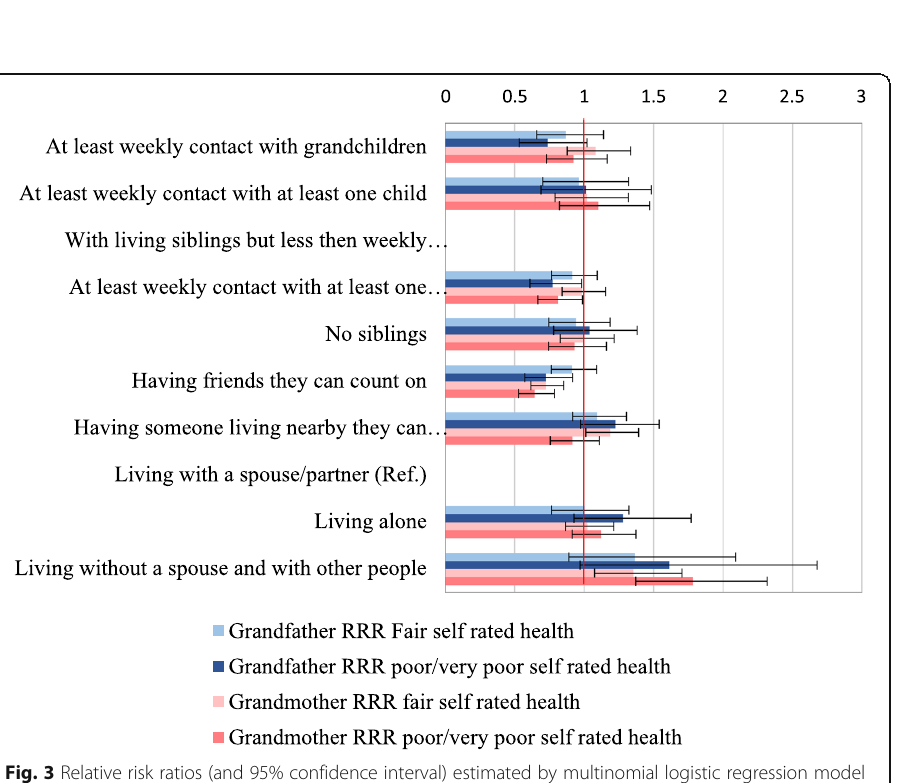
Fig. 2 Relative risk ratios (and 95% confidence interval) estimated by multinomial logistic regression model on limiting problems (ref. no limiting problems). RRR are adjusted for age, educational level (high/medium or low), living area (North, Centre or South of Italy), subjective financial situation, and working status